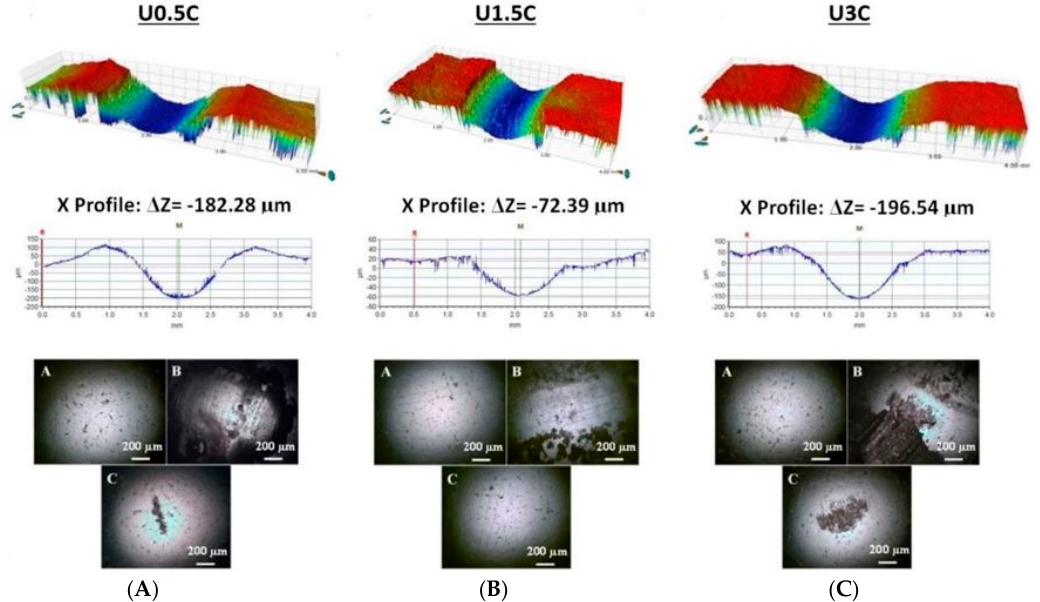
Figure 5. 3D and 2D profiles and counterface ball images after the wear test conducted on UHMWPE nanocomposite coating, recorded at a normal load of 12 N and a sliding velocity of 0.1 m/s for 50,000 cycles. ( A ) U0.5C; ( B ) U1.5C; ( C ) U3C.